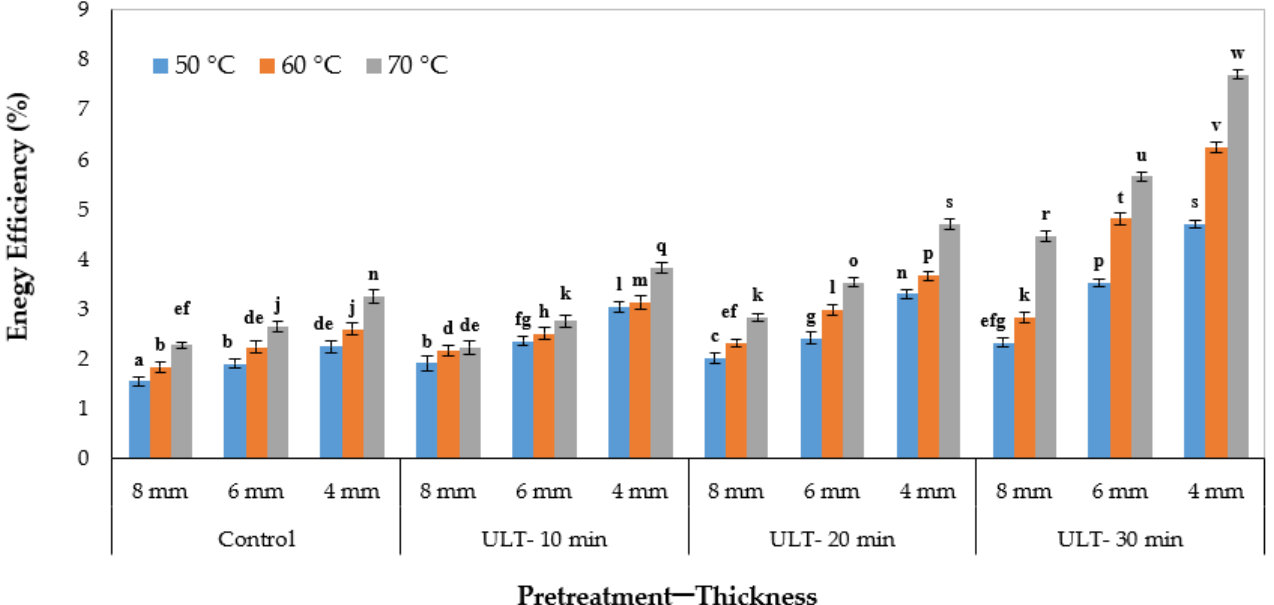
Figure 4. Energy efficiency under different conditions for kiwifruit slices drying.